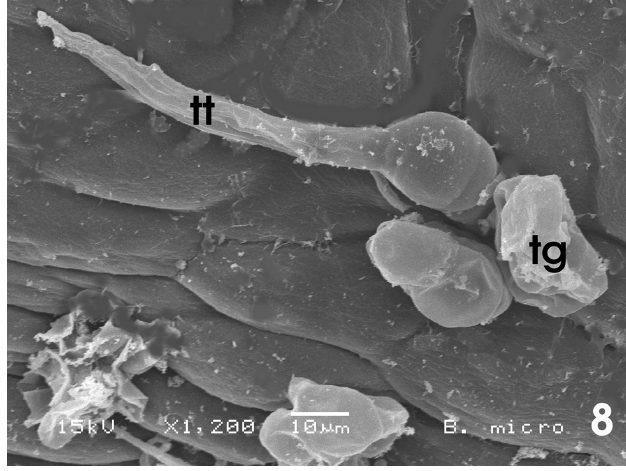
FIGURA 4 – B. trimera – Diagrama da secção transversal do cladódio. al: ala; cx: córtex; fi: fibras esclerenquimáticas; fl: floema; me: medula; xi: xilema. Barra = 100 µ m.